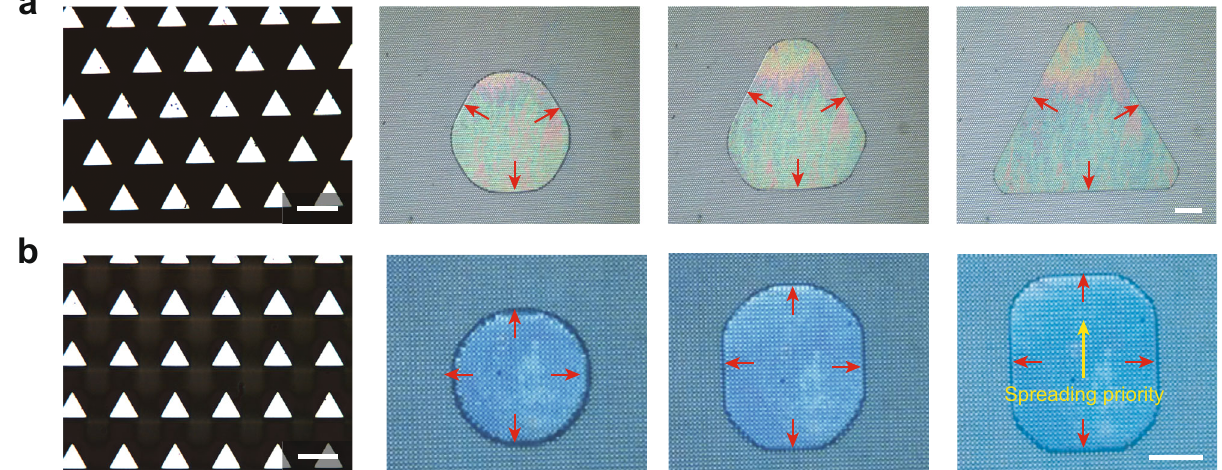
Fig. 6 Evolution of the morphology and spreading priority of the contact line on surfaces with a triangular cross-section of the pillars and various arrangements of the arrays. The red arrows represent the block directions. a The liquid spreads synchronously (Supplementary Movie 4). b One side (top side) of the square liquid moves along the direction (yellow arrow) pointing at one vertex of a single pillar (Supplementary Movie 1). Scale bar of the pillars, 20 μ m. Scale bar of the droplet patterns, 250 μ